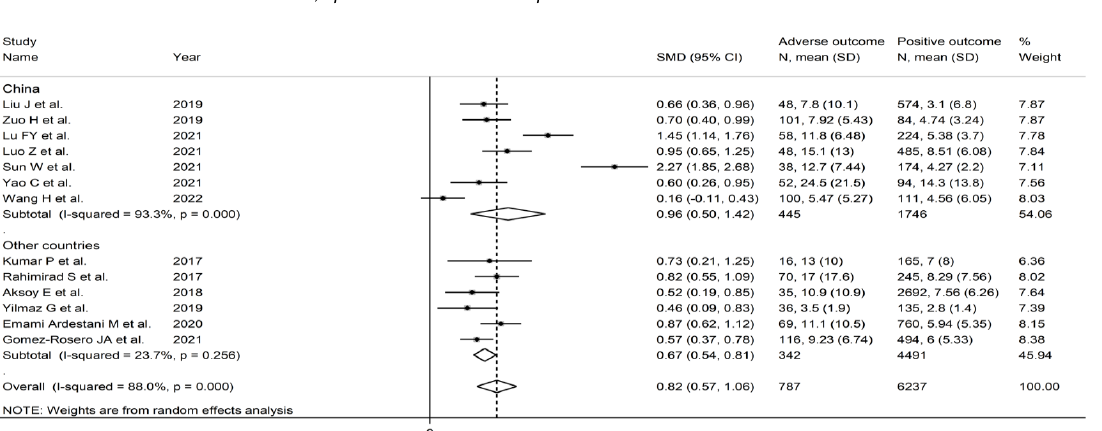
Figure 12. Forest plot of the association between the neutrophil-to-lymphocyte ratio, using standard mean differences, and adverse outcomes according to the country where the study was performed (China vs. other countries). p = 0.000 indicates a p -value < 0.001.